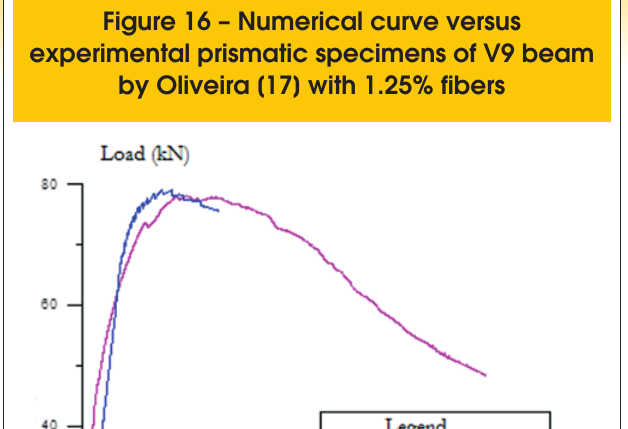
Figure 17 – Numerical curve versus experimental prismatic specimens of V8 beam by Oliveira [17] with 0.75%